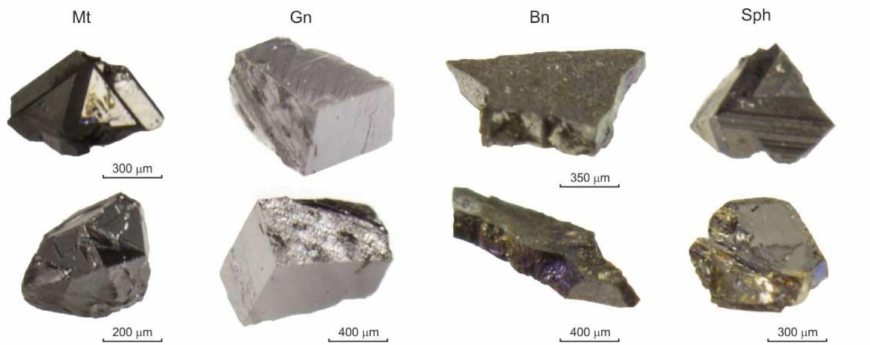
Figure 1. Crystals of magnetite (Mt), galena (Gn), bornite (Bn) and sphalerite (Sph) synthesised in